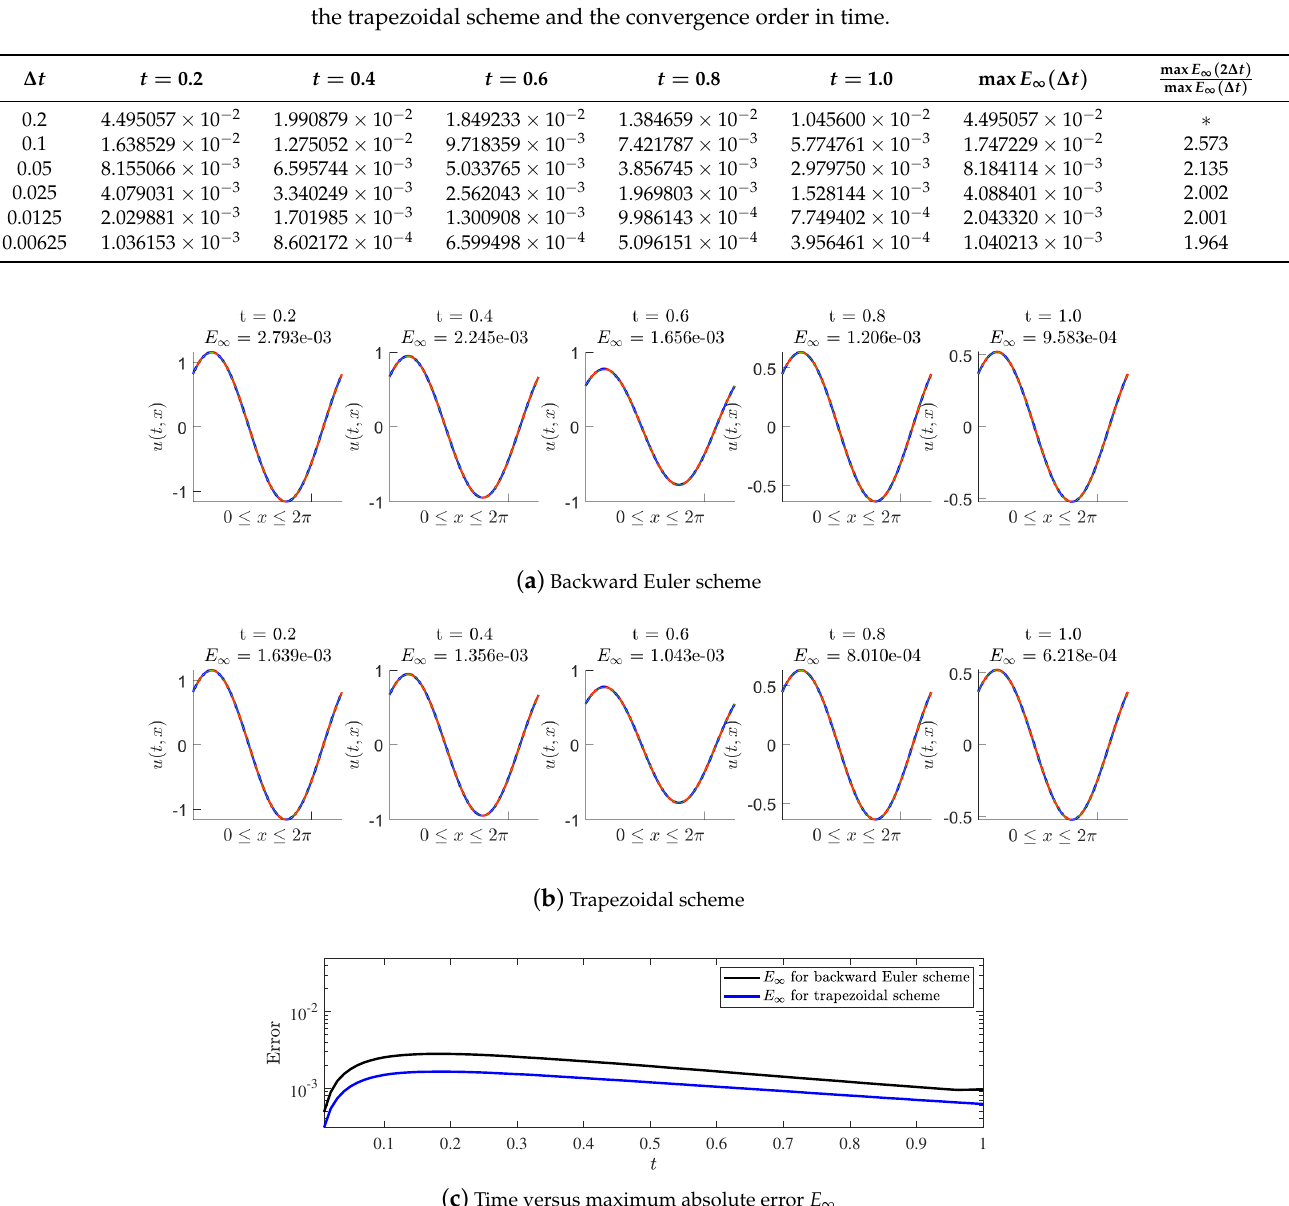
Figure 8. Problem of Example 1: ( a ) The posterior distribution of the predicted solution at different time nodes, where the backward Euler scheme is used. Fix the number of initial data points (inho- mogeneous term data points, artificially generated data points and delay term data points) to be 30, and take ∆ t = 0.01. ( b ) The posterior distribution of the predicted solution at different time nodes, where the trapezoidal scheme is used. The other experimental conditions are the same as those with the backward Euler scheme. ( c ) Time versus maximum absolute error E ∞ until the final time step is reached, where the backward Euler scheme and the trapezoidal scheme are both